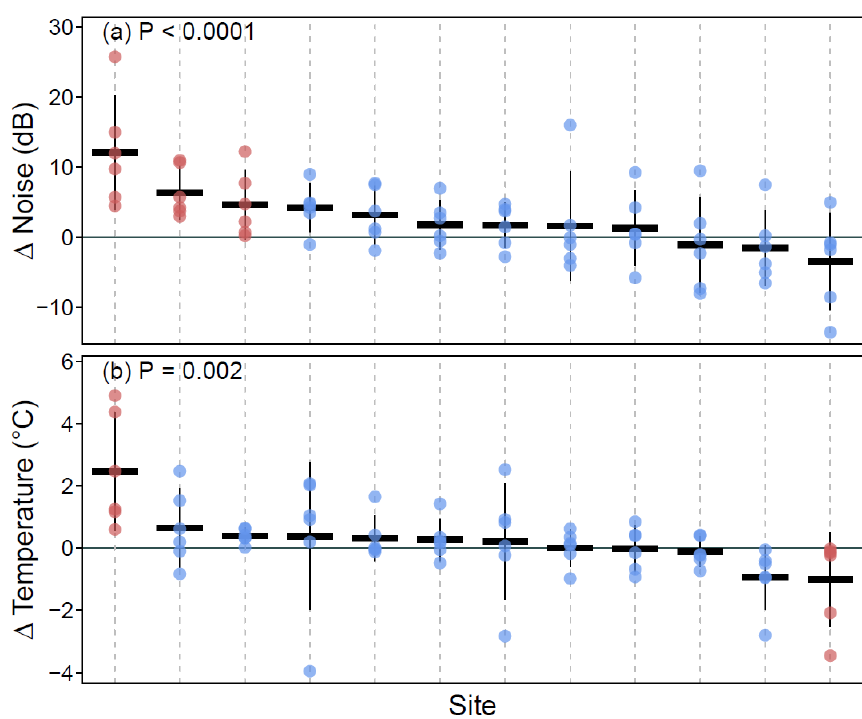
Figure 6. Plots of ∆ noise ( a ) and ∆ temperature ( b ). Red points are the individual sites that are significantly di ff erent from their respective reference sites, and blue points are sites where no significant site-wise di ff erences were observed. Thick black horizontal lines indicate site means, and thin vertical black lines show the 95% confidence interval of the mean for the sites. The p -value at the top of each plot is the result from a joint test of model coe ffi cients with the null hypothesis that the sites do not di ff er from zero. Sites are sorted on the x -axis by their mean value (highest to lowest) for ease in interpretation. The solid horizontal line indicates zero on the y -axis, representing equal values of noise ( a ) or temperature ( b ) at the green wall and reference